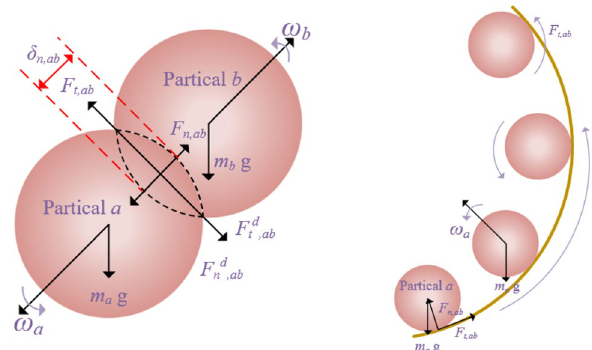
Figure 1. Schematic diagram of particle